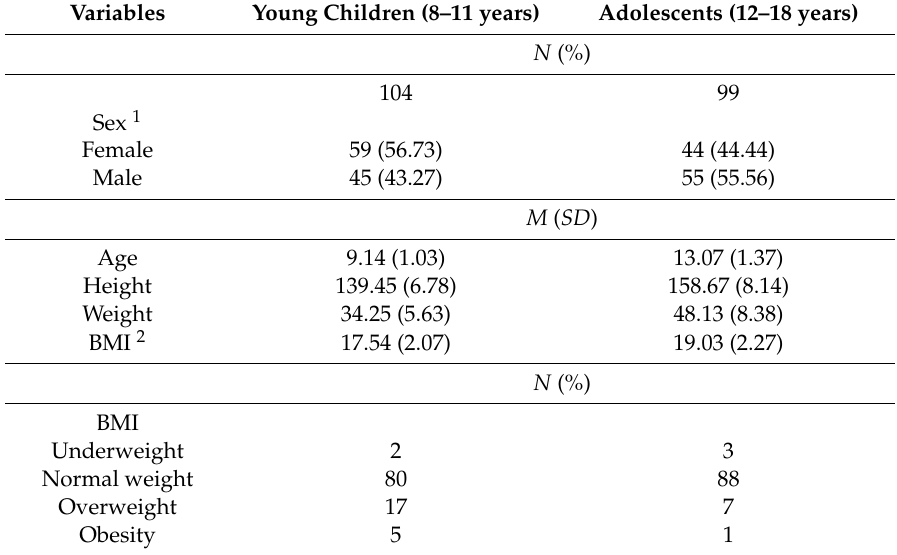
Table 1. Descriptive statistics for the two age